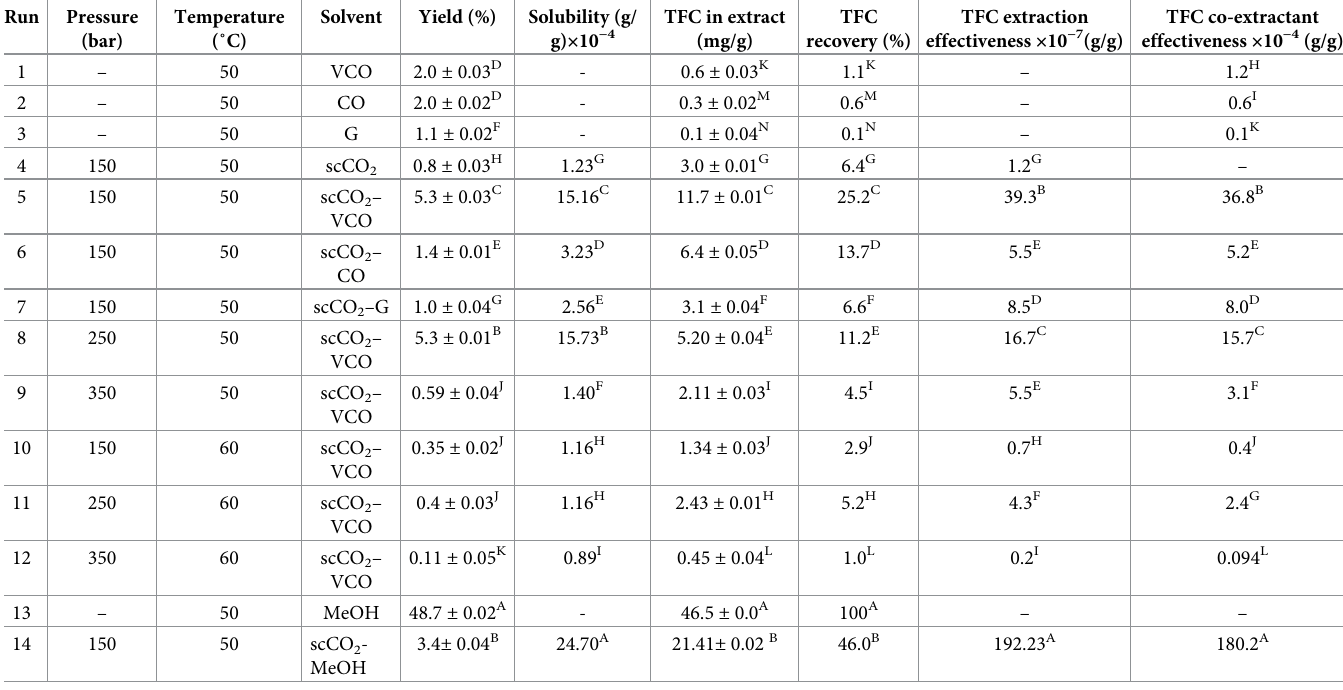
Table 2. Comparison of methods for the extraction of flavonoids from the